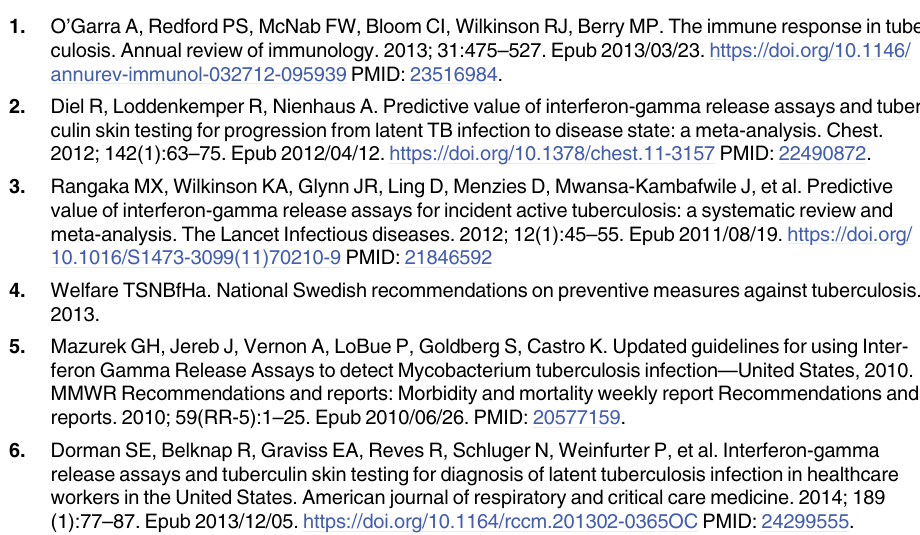
S1 Table. QFT results for initial and follow up samples separated for subjects retested within or beyond 4